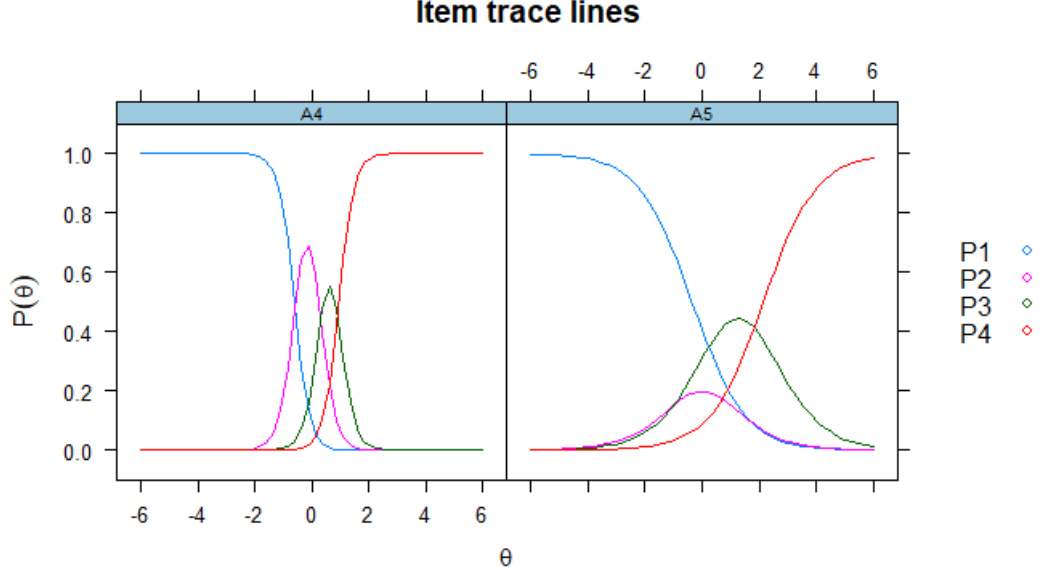
Figure 10. Component ICCs of Time Domain Needs component.